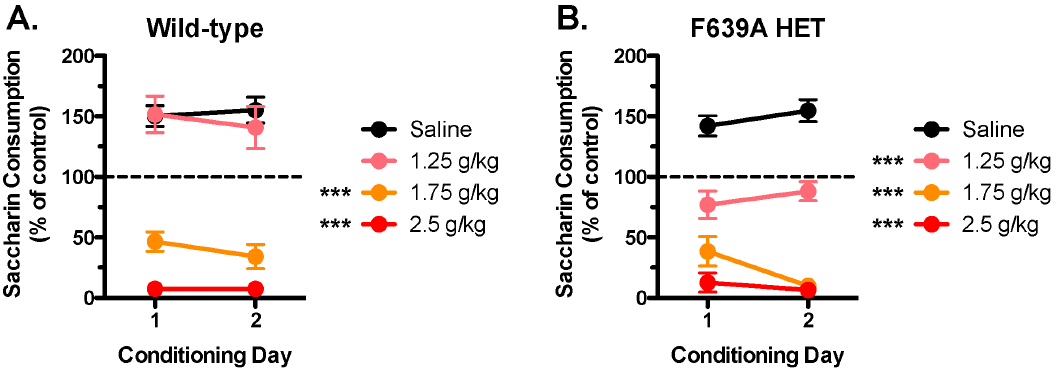
Figure 10. F639A Het mice show altered conditioned taste aversion to a low dose of ethanol as compared to wild-type mice. Graphs show percent of baseline saccharin solution consumed after repeated pairings with an injection of saline, 1.25 g/kg, 1.75 g/kg, or 2.5 g/kg of ethanol in ( A ) wild-type, and ( B ) F639A Het mice (n=6–7 for each group). Symbol ( * ): value significantly different from saline ( *** p , 0.001, two-way RM ANOVA, Bonferroni’s post hoc test). Values are mean 6